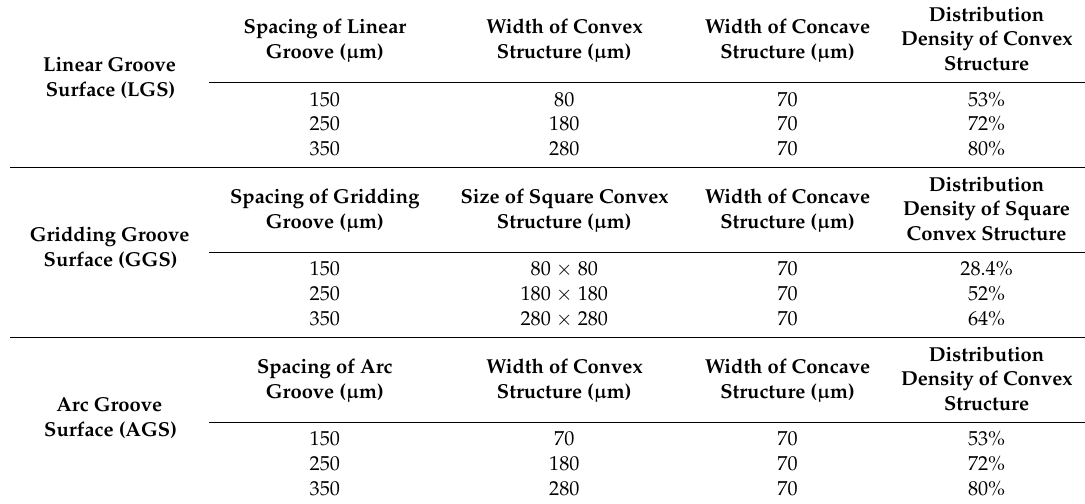
Figure 3. SEM images of the morphology of the micro ‐ scale structure surfaces (texture spacing of 250 μ m): ( a ) linear grooves, ( b ) gridding groove, ( c ) arc grooves (the insets correspond to their high ‐ magnification SEM images). Table 2. Dimensions of micro ‐ scale structures of the as ‐ prepared surfaces.